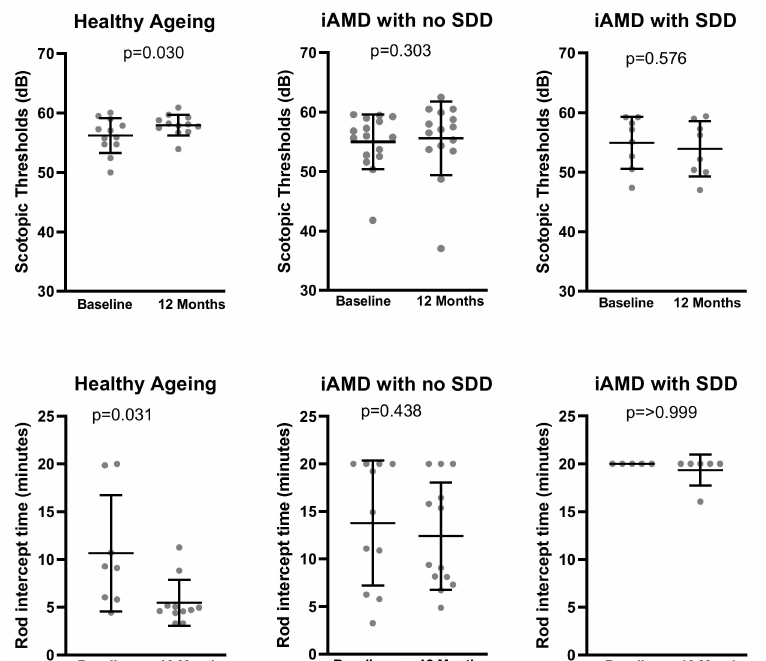
Figure 1. Scatter plots showing change in scotopic thresholds and rod-intercept time (RIT) from baseline to 12 months for 670 nm trial participants. Error bars represent the mean with standard deviation. Only assessments with less than 33% fixation error are displayed in RIT plots. (iAMD = intermediate AMD; SDD = subretinal drusenoid